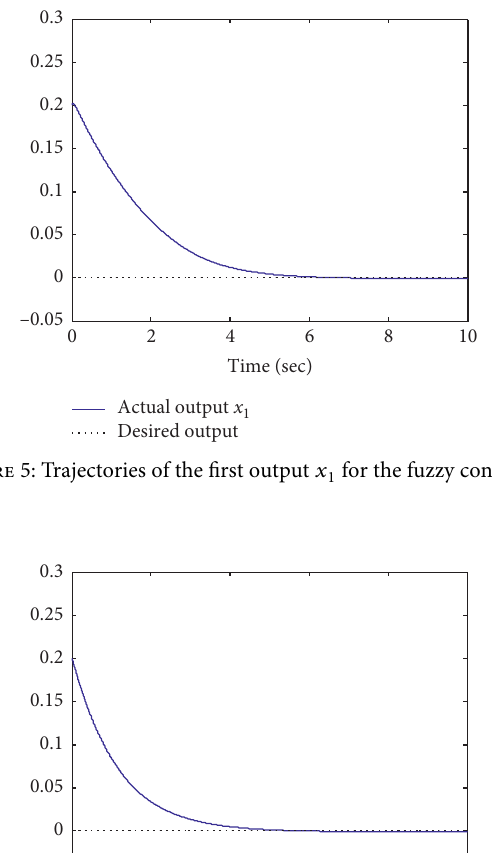
for our controller. 1